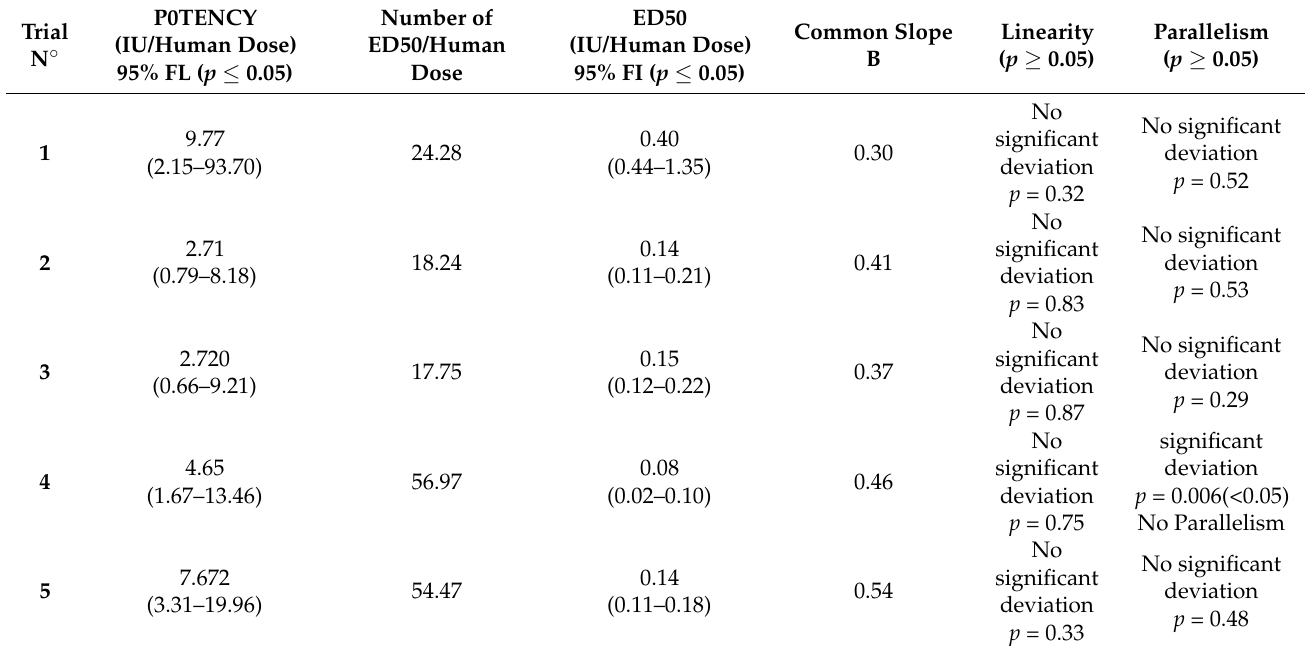
Table 3. Results of the estimation of the relative potency and protective dose ED50 of the five trials performed on the pertussis component of DTP test vaccine (Vaccine test 1, 2, 3,